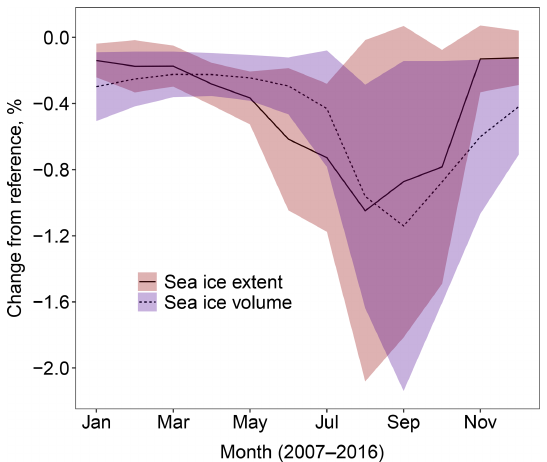
Figure 3. Difference in sea ice extent (solid, red ribbon) and volume (dashed, blue ribbon) between stan-fsd relative to ref (using a con- stant floe size) averaged over 2007–2016. The ribbon shows, in each case, the region spanned by the mean value plus or minus 2 times the standard deviation for each simulation. This gives a measure of the interannual variability over the 10-year period. The mean be- haviour is a reduction in the sea ice extent and volume, with losses of up to 1% and 1.2% respectively seen in September during the period of minimum sea ice. The interannual variability shows that the impact of the WIPoFSD model with standard parameters varies significantly between years, with some years potentially showing negligible change in extent and volume and others showing a max- imum reduction of over 2%.